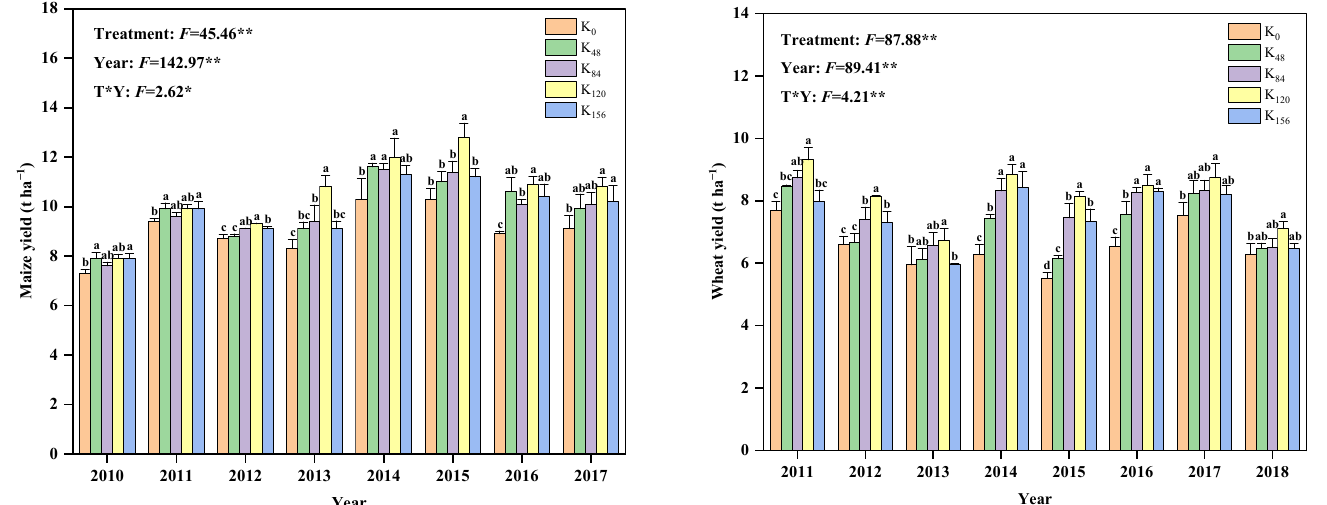
Figure 1. Effects of different K fertilization rates on maize and wheat yield between 2010 and 2018. K 0 , no K fertilizer application; K 48 , 48 kg K ha − 1 ; K 84 , 84 kg K ha − 1 ; K 120 , 120 kg K ha − 1 ; K 156 , 156 kg K ha − 1 . Vertical T bars in the histogram indicate SE. Different letters indicate significant differences among treatments. Lowercase letters represent significant differences between different fertilization treatments in the same year ( p < 0.05). * Significant at the 0.05 probability level. ** Significant at the 0.01 probability